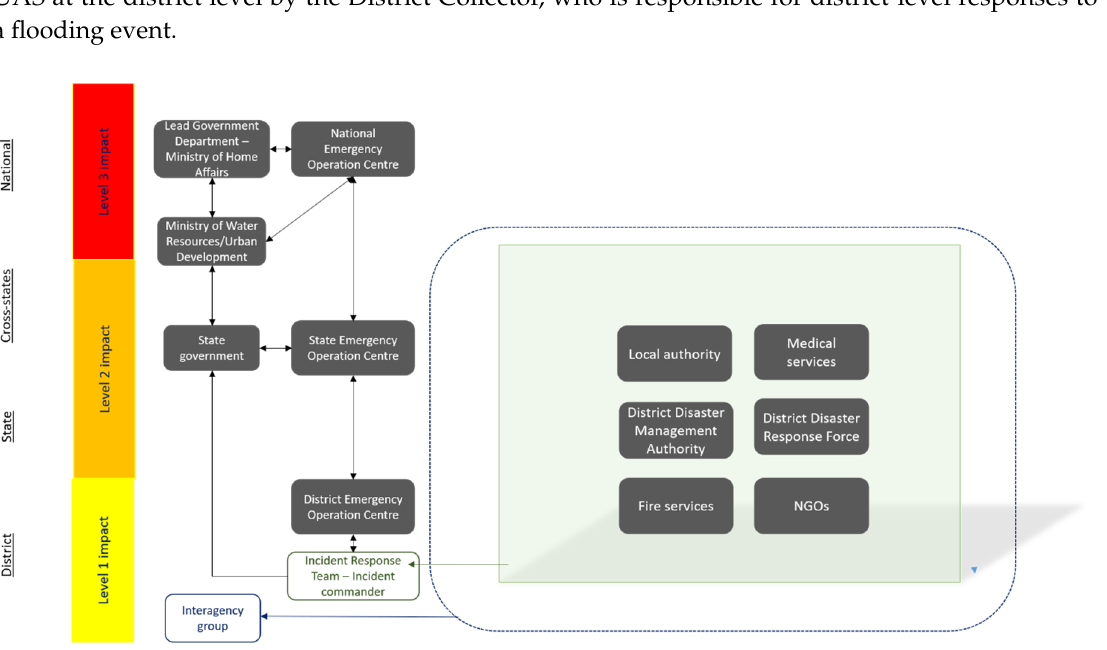
Figure 3. Schematic diagram of flood emergency response in India showing the main agencies and groups involved and the levels of emergency responses (level 1, level 2 and level 3) which depends upon the flood extent (district, state, cross-states, national).